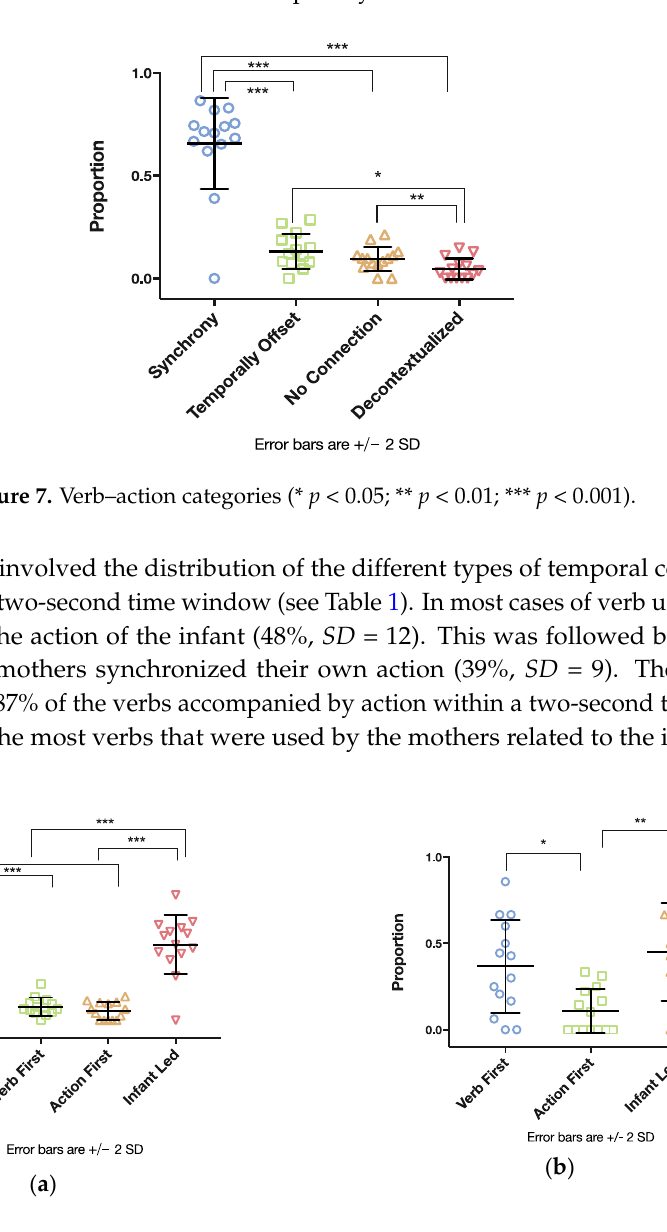
Figure 8. ( a ) Types of temporal coordination within a two-second time window. ( b ) Types of temporal coordination offset by more than 2 s (* p < 0.05; ** p < 0.01; *** p < 0.001).